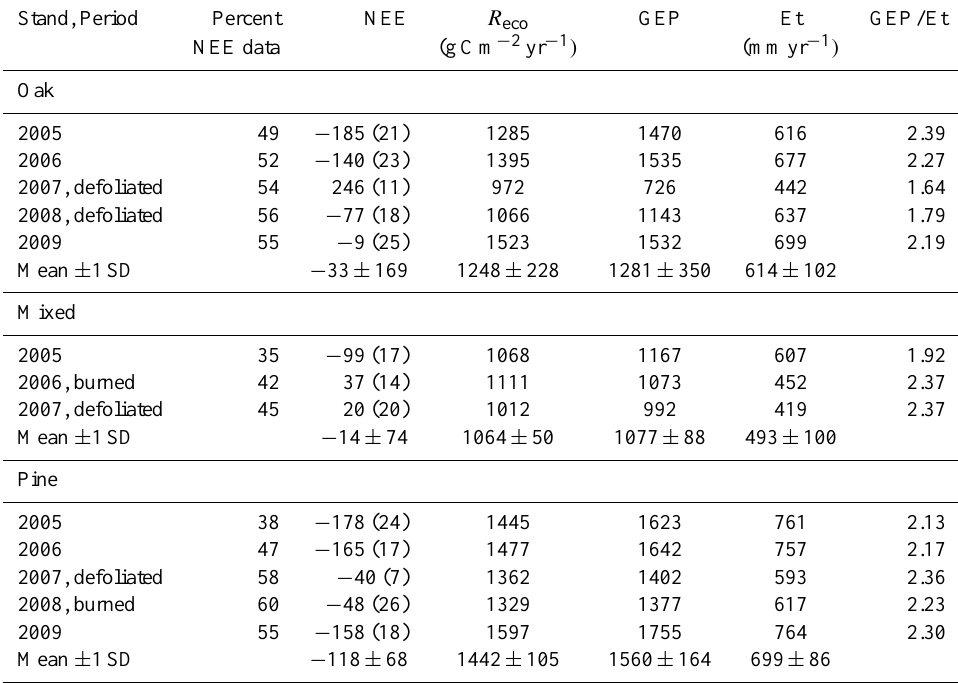
Table 6. Annual net CO 2 exchange (NEE), ecosystem respiration ( R eco ) , gross ecosystem production (GEP, gCm − 2 yr − 1 ) , evapotranspi- ration (Et, mmyear − 1 ) , and the ratio of GEP to ET for the oak, mixed, and pine stands. Percent filtered half-hourly NEE data for each year used to calculate annual NEE, R eco and GEP are shown in the first column. Values in parentheses for NEE are maximum deviations from annual values as a result of gap filling using ± 1 standard error of daytime or nighttime parameters. Stand, Period Percent NEE R eco GEP Et GEP/Et NEE data (gCm − 2 yr − 1 ) (mmyr − 1